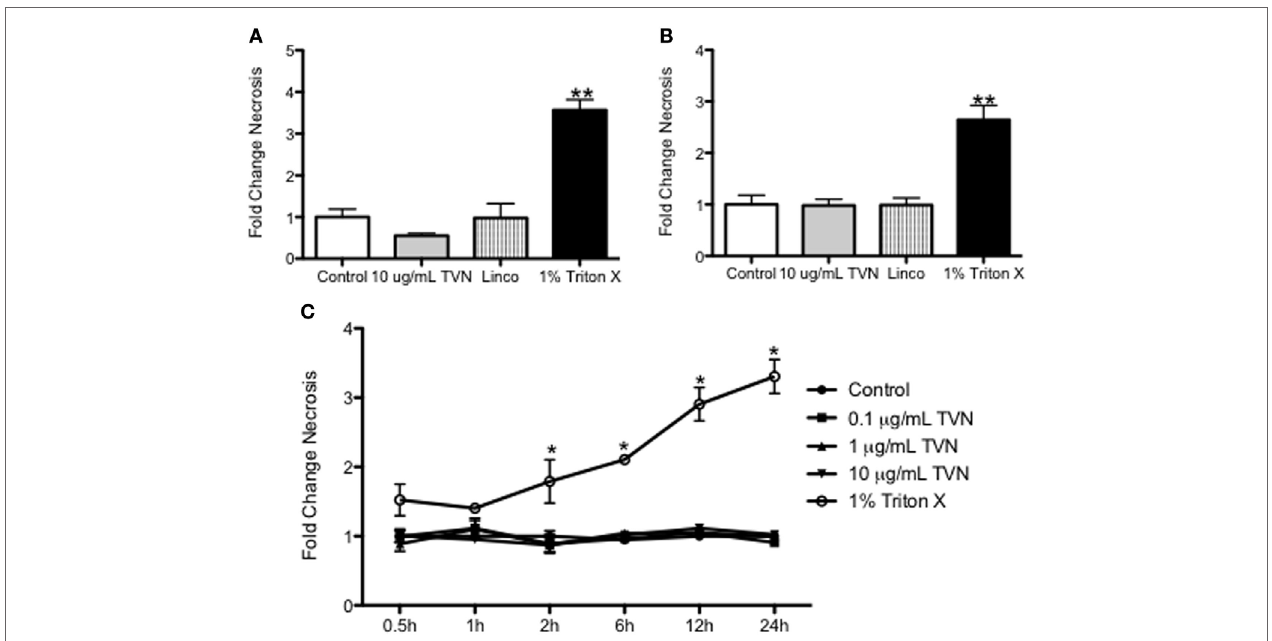
FigUre 3 | Tylvalosin has no significant effect on resting cell necrosis in vitro. Secreted lactate dehydrogenase (LDH) was measured to assess cell necrosis, by quantifying the amount of LDH protein in cell culture supernatants. Porcine neutrophils were incubated with control (10% FBS in HBSS), 10 μ g/mL tylvalosin, equimolar concentrations of lincomysin (linco; 11 μ M) and 1% Triton X-100 (positive control). These values were then expressed as a fold change compared to the vehicle at (a) 0.5 and (B) 1 h. Values are mean ± SEM ( n = 9), ** P < 0.01. (c) Cell necrosis (measured by LDH release) in porcine monocyte-derived macrophages incubated with control (10% FBS in IMDM), tylvalosin (0.1, 1, or 10 μ g/mL), or 1% Triton X-100 (positive control) for 0.5–24 h. Values were expressed as a fold change compared as a ratio to control. Values among controls and tylvalosin-treated cells did not differ among each other ( n = 6–9/group). Data are mean ± SEM, * P < 0.05 versus